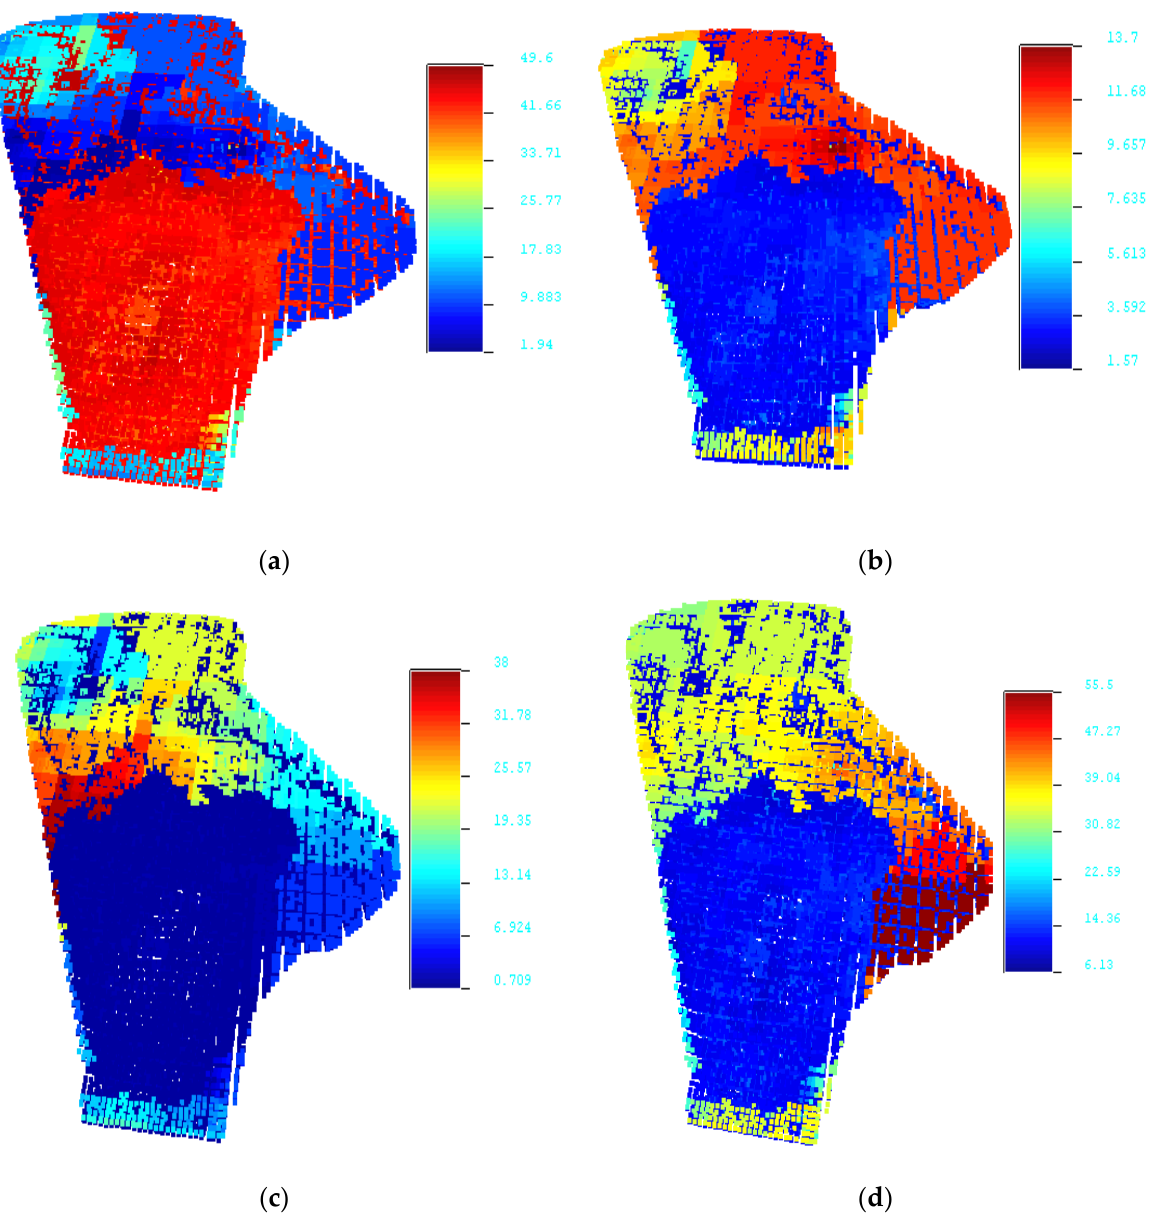
Figure 3. Resource models of CaO, Al 2 O 3 , SiO 2 , and Fe 2 O 3 for the northern block. ( a ) CaO; ( b ) Al 2 O 3 ; ( c ) Fe 2 O 3 ; ( d ) SiO 2 .